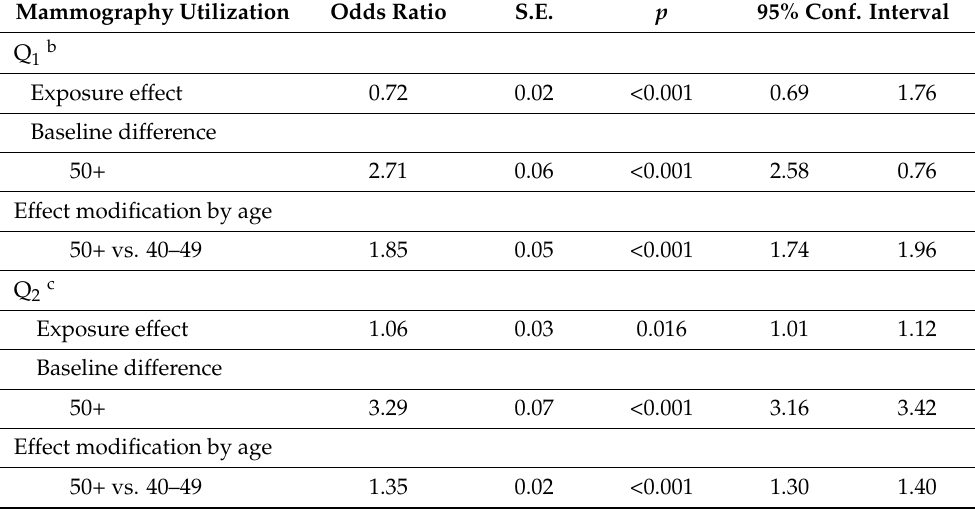
Table 5. Multiple logistic regression of mammography utilization based on IT-based